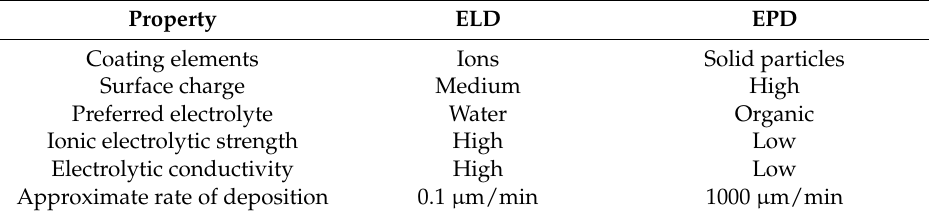
Figure 6. Sketch of the electrophoretic deposition process [60]. Table 1. Characteristics of electrodeposition techniques [61].